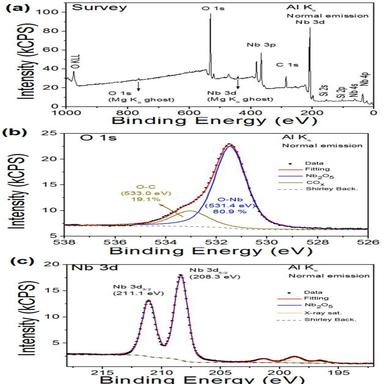
XPS survey spectrum of the Ti6Al4V alloy surface containing Nb2O5 thin film (a) chemical composition, (b) O 1s, and (c) Nb 3d levels.